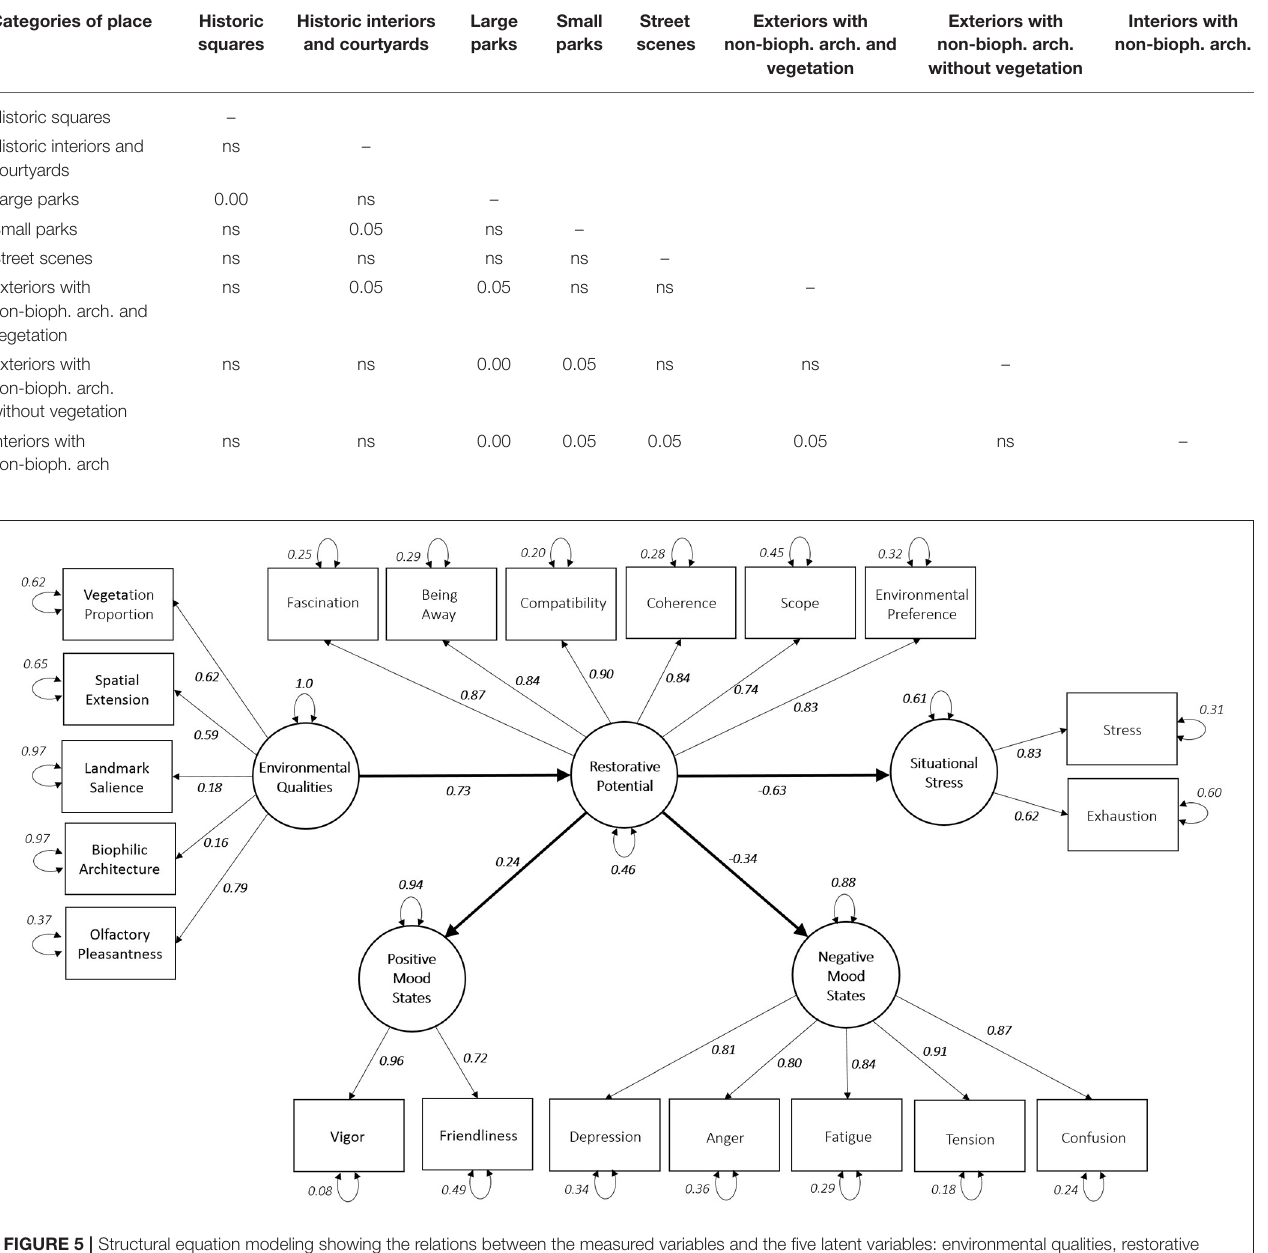
FIGURE 5 | Structural equation modeling showing the relations between the measured variables and the five latent variables: environmental qualities, restorative potential (including all the EPRA-R dimensions), positive mood states, negative mood states, and situational stress. Model fit indexes, CFI = 0.96, RMSEA = 0.05, SRMR =